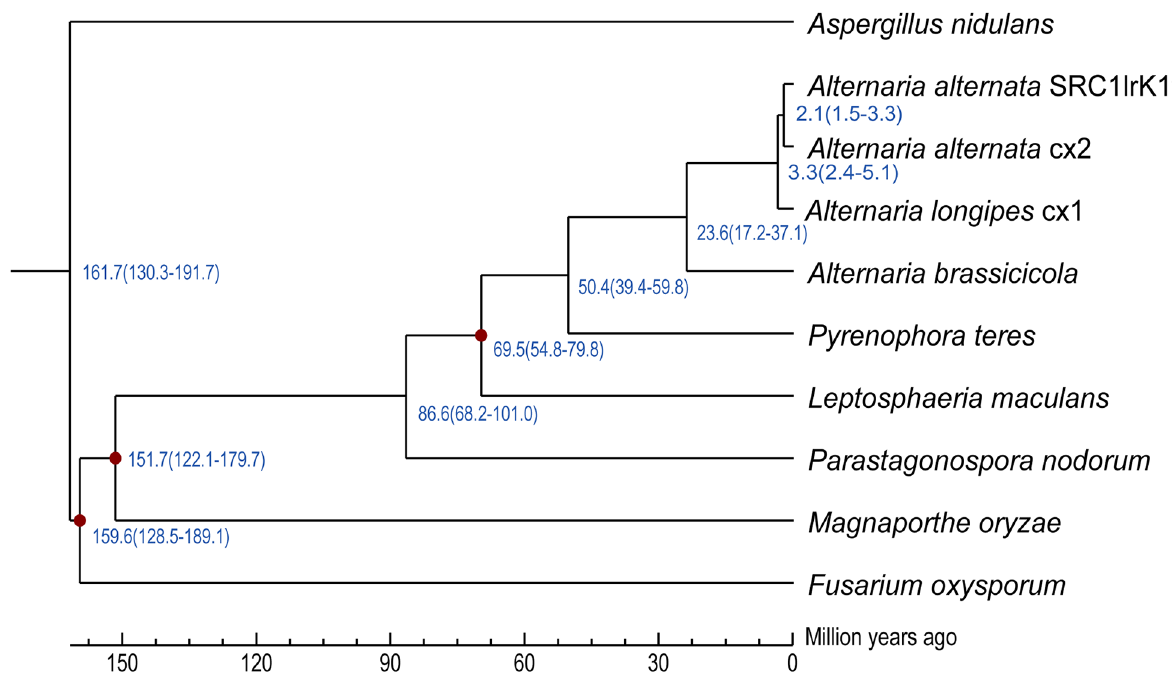
Fig 5. Phylogenetic relationship among A . longipes cx1, A . alternata cx2, F . oxysporum , M . oryzae , A . nidulans , L . maculans , P . teres , P . nodorum , A . abrassicicola and A . alternata SRC1lrK1f. The estimates of divergence time and its interval based on sequence identity are indicated at each node. The red dot on branches means divergence time has been adjusted by fossil evidence.